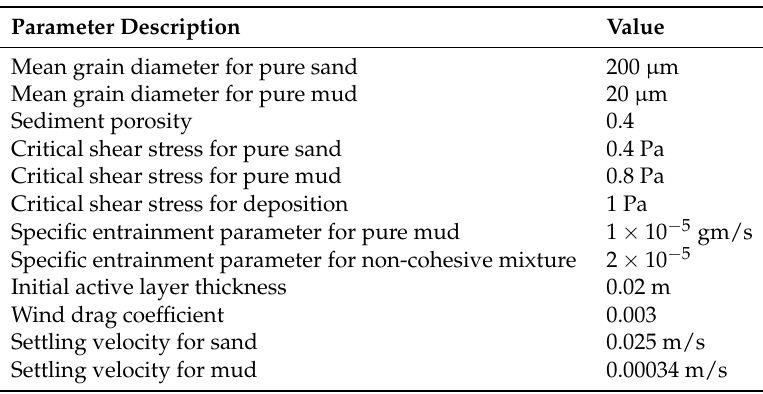
Table 2. Parameters used in the WWTM and STABEM